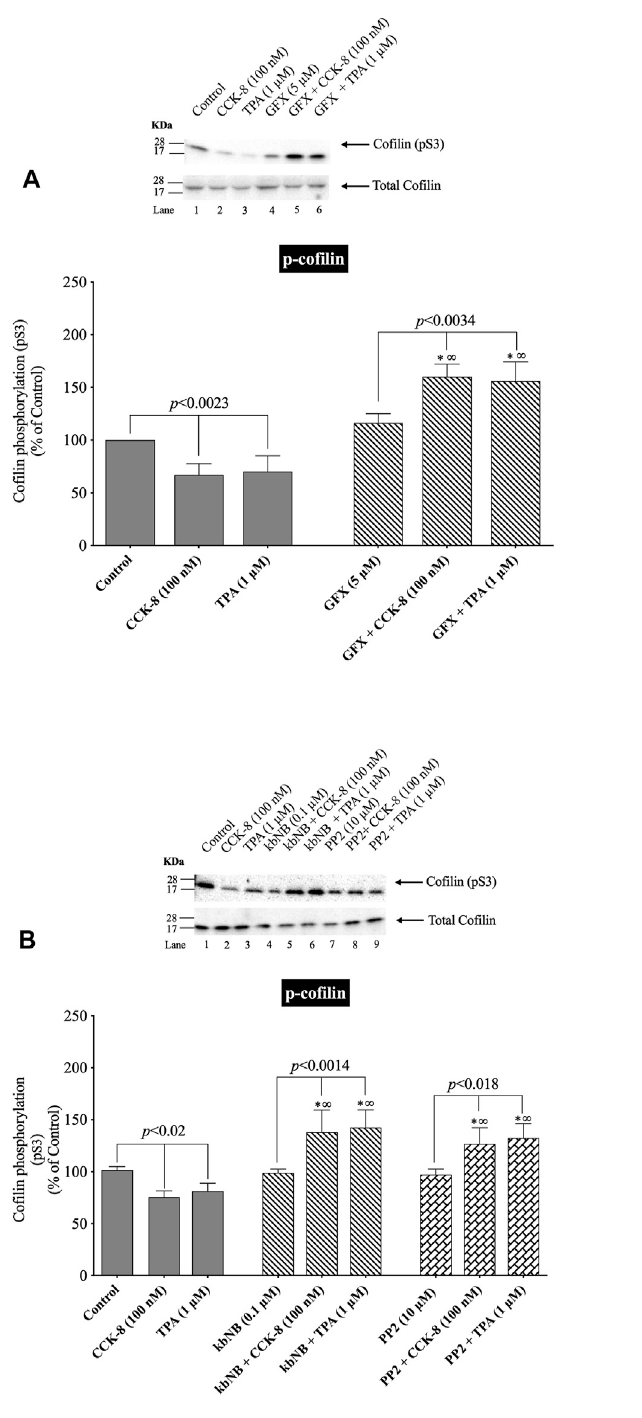
FIGURE 7 Effect of a PKC inhibitor, GFX; PKD inhibitor, kbNB; or a Src inhibitor, PP2, on the ability of CCK-8 (100 nM) and TPA (1 µM) to alter co fi lin activation. Isolated pancreatic acini were incubated in the absence or presence of GFX (5 µM) (A) , kbNB (0.1 µM) (B) or PP2 (10 µM) (B) for 3 h and then incubated with no addition (control), CCK-8 (100 nM, 3 min) or TPA (1 μ M, 5 min), and then lysed. Western blots were analyzed using anti-pS3 co fi lin. Bands were visualized using chemiluminescence and quanti fi ed by densitometry. Top : Results of a representative blot of four independent experiments are shown. Bottom : Means ± S.E. of at least 4 independent experiments. Results are expressed as % of basal stimulation of the control group. *, p < 0.05 compared to the control group; ∞ , p < 0.05 compared to stimulants without